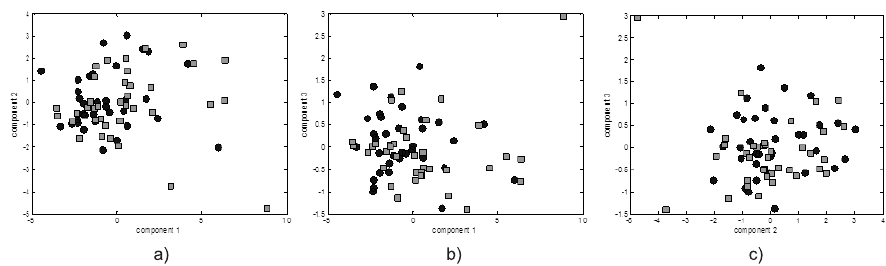
Figure 7. Observations divided into treatment and control groups on principal component axes